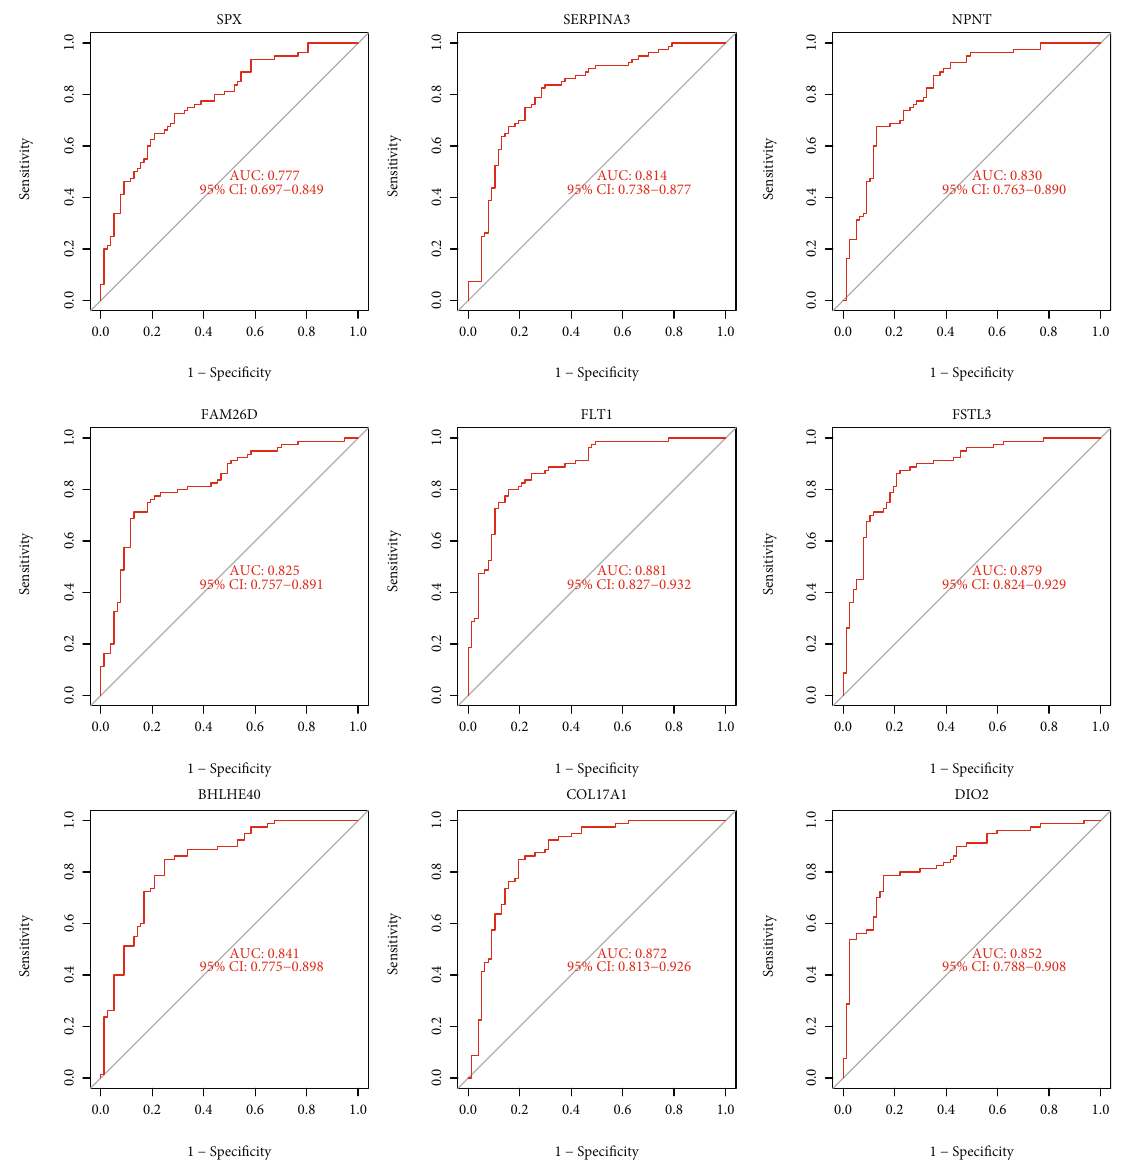
Figure 6: The diagnostic value of the 9 critical genes was studied using ROC assays in cells memory in a negative way, including neutrophils and 21 di ff erent immune cell pro fi les built from samples of renal fi macrophages M2 (Figure 9(b) and Figure S2). FSTL3 was positively correlated with plasma cells, eosinophils, B cells